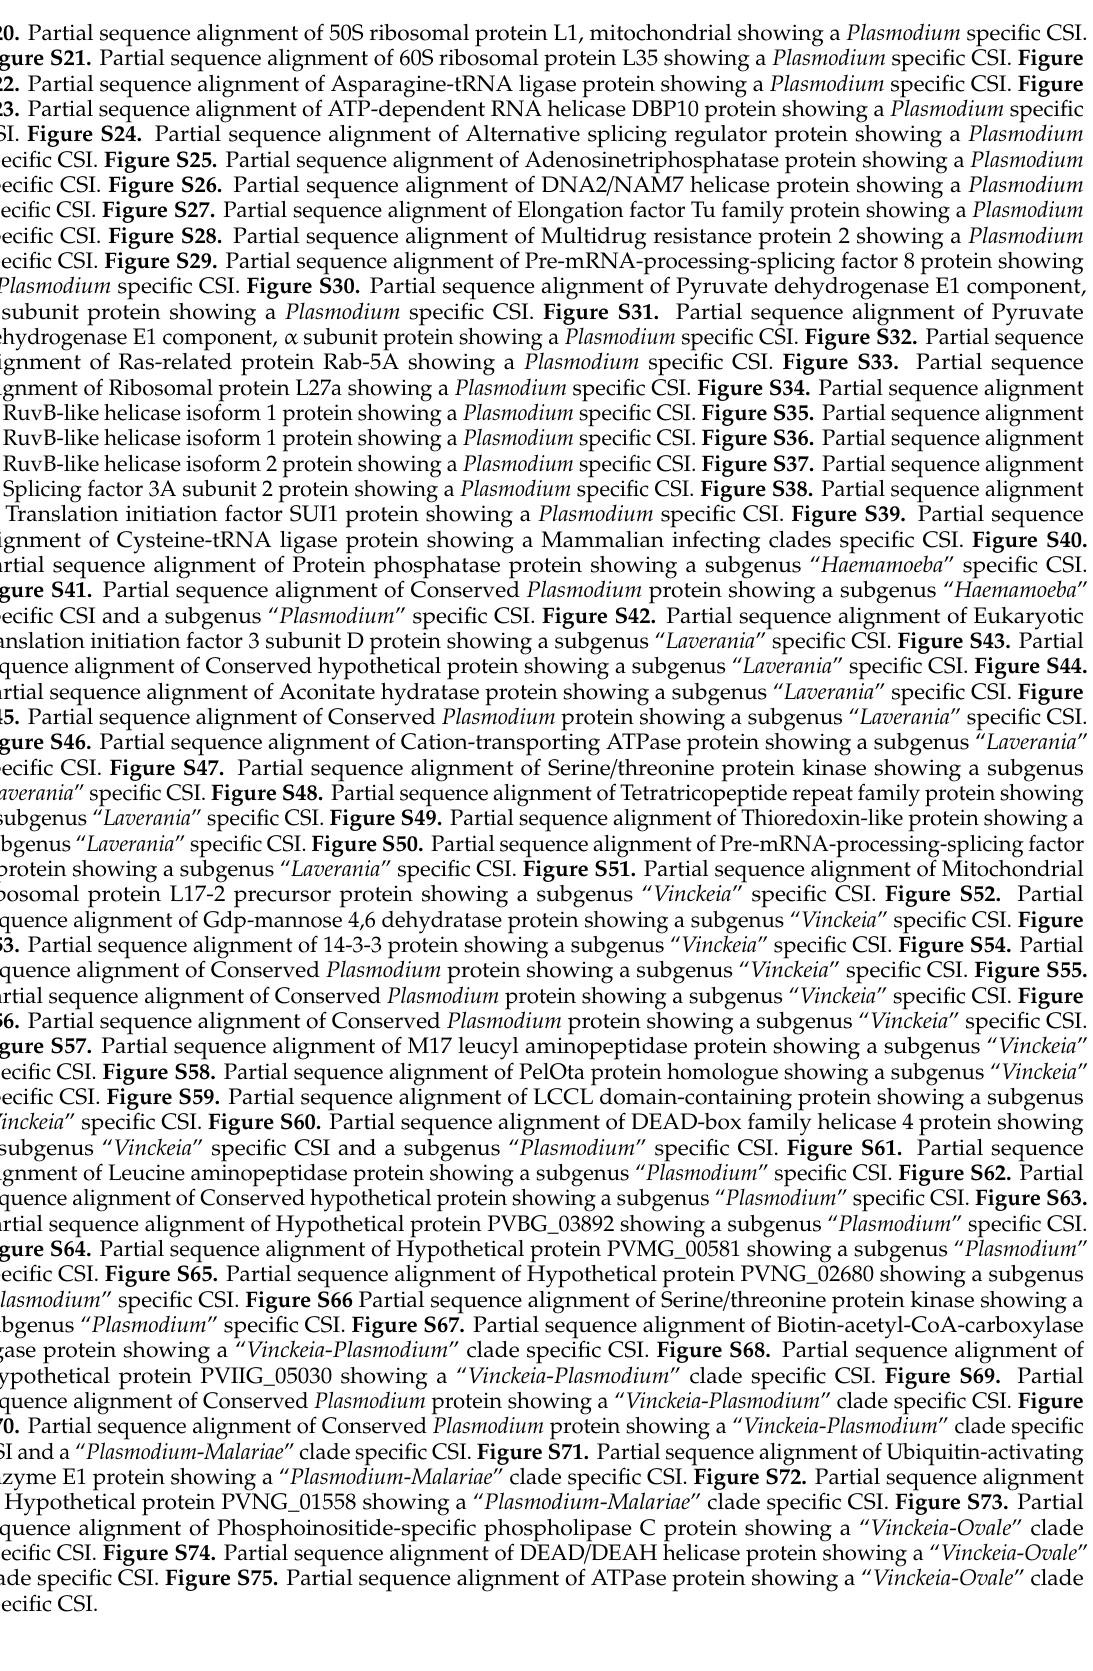
S20. Partial sequence alignment of 50S ribosomal protein L1, mitochondrial showing a Plasmodium specific CSI. Figure S21. Partial sequence alignment of 60S ribosomal protein L35 showing a Plasmodium specific CSI. Figure S22. Partial sequence alignment of Asparagine-tRNA ligase protein showing a Plasmodium specific CSI. Figure S23. Partial sequence alignment of ATP-dependent RNA helicase DBP10 protein showing a Plasmodium specific CSI. Figure S24. Partial sequence alignment of Alternative splicing regulator protein showing a Plasmodium specific CSI. Figure S25. Partial sequence alignment of Adenosinetriphosphatase protein showing a Plasmodium specific CSI. Figure S26. Partial sequence alignment of DNA2 / NAM7 helicase protein showing a Plasmodium specific CSI. Figure S27. Partial sequence alignment of Elongation factor Tu family protein showing a Plasmodium specific CSI. Figure S28. Partial sequence alignment of Multidrug resistance protein 2 showing a Plasmodium specific CSI. Figure S29. Partial sequence alignment of Pre-mRNA-processing-splicing factor 8 protein showing a Plasmodium specific CSI. Figure S30. Partial sequence alignment of Pyruvate dehydrogenase E1 component, α subunit protein showing a Plasmodium specific CSI. Figure S31. Partial sequence alignment of Pyruvate dehydrogenase E1 component, α subunit protein showing a Plasmodium specific CSI. Figure S32. Partial sequence alignment of Ras-related protein Rab-5A showing a Plasmodium specific CSI. Figure S33. Partial sequence alignment of Ribosomal protein L27a showing a Plasmodium specific CSI. Figure S34. Partial sequence alignment of RuvB-like helicase isoform 1 protein showing a Plasmodium specific CSI. Figure S35. Partial sequence alignment of RuvB-like helicase isoform 1 protein showing a Plasmodium specific CSI. Figure S36. Partial sequence alignment of RuvB-like helicase isoform 2 protein showing a Plasmodium specific CSI. Figure S37. Partial sequence alignment of Splicing factor 3A subunit 2 protein showing a Plasmodium specific CSI. Figure S38. Partial sequence alignment of Translation initiation factor SUI1 protein showing a Plasmodium specific CSI. Figure S39. Partial sequence alignment of Cysteine-tRNA ligase protein showing a Mammalian infecting clades specific CSI. Figure S40. Partial sequence alignment of Protein phosphatase protein showing a subgenus “ Haemamoeba ” specific CSI. Figure S41. Partial sequence alignment of Conserved Plasmodium protein showing a subgenus “ Haemamoeba ” specific CSI and a subgenus “ Plasmodium ” specific CSI. Figure S42. Partial sequence alignment of Eukaryotic translation initiation factor 3 subunit D protein showing a subgenus “ Laverania ” specific CSI. Figure S43. Partial sequence alignment of Conserved hypothetical protein showing a subgenus “ Laverania ” specific CSI. Figure S44. Partial sequence alignment of Aconitate hydratase protein showing a subgenus “ Laverania ” specific CSI. Figure S45. Partial sequence alignment of Conserved Plasmodium protein showing a subgenus “ Laverania ” specific CSI. Figure S46. Partial sequence alignment of Cation-transporting ATPase protein showing a subgenus “ Laverania ” specific CSI. Figure S47. Partial sequence alignment of Serine / threonine protein kinase showing a subgenus “ Laverania ” specific CSI. Figure S48. Partial sequence alignment of Tetratricopeptide repeat family protein showing a subgenus “ Laverania ” specific CSI. Figure S49. Partial sequence alignment of Thioredoxin-like protein showing a subgenus “ Laverania ” specific CSI. Figure S50. Partial sequence alignment of Pre-mRNA-processing-splicing factor 8 protein showing a subgenus “ Laverania ” specific CSI. Figure S51. Partial sequence alignment of Mitochondrial ribosomal protein L17-2 precursor protein showing a subgenus “ Vinckeia ” specific CSI. Figure S52. Partial sequence alignment of Gdp-mannose 4,6 dehydratase protein showing a subgenus “ Vinckeia ” specific CSI. Figure S53. Partial sequence alignment of 14-3-3 protein showing a subgenus “ Vinckeia ” specific CSI. Figure S54. Partial sequence alignment of Conserved Plasmodium protein showing a subgenus “ Vinckeia ” specific CSI. Figure S55. Partial sequence alignment of Conserved Plasmodium protein showing a subgenus “ Vinckeia ” specific CSI. Figure S56. Partial sequence alignment of Conserved Plasmodium protein showing a subgenus “ Vinckeia ” specific CSI. Figure S57. Partial sequence alignment of M17 leucyl aminopeptidase protein showing a subgenus “ Vinckeia ” specific CSI. Figure S58. Partial sequence alignment of PelOta protein homologue showing a subgenus “ Vinckeia ” specific CSI. Figure S59. Partial sequence alignment of LCCL domain-containing protein showing a subgenus “ Vinckeia ” specific CSI. Figure S60. Partial sequence alignment of DEAD-box family helicase 4 protein showing a subgenus “ Vinckeia ” specific CSI and a subgenus “ Plasmodium ” specific CSI. Figure S61. Partial sequence alignment of Leucine aminopeptidase protein showing a subgenus “ Plasmodium ” specific CSI. Figure S62. Partial sequence alignment of Conserved hypothetical protein showing a subgenus “ Plasmodium ” specific CSI. Figure S63. Partial sequence alignment of Hypothetical protein PVBG_03892 showing a subgenus “ Plasmodium ” specific CSI. Figure S64. Partial sequence alignment of Hypothetical protein PVMG_00581 showing a subgenus “ Plasmodium ” specific CSI. Figure S65. Partial sequence alignment of Hypothetical protein PVNG_02680 showing a subgenus “ Plasmodium ” specific CSI. Figure S66 Partial sequence alignment of Serine / threonine protein kinase showing a subgenus “ Plasmodium ” specific CSI. Figure S67. Partial sequence alignment of Biotin-acetyl-CoA-carboxylase ligase protein showing a “ Vinckeia - Plasmodium ” clade specific CSI. Figure S68. Partial sequence alignment of Hypothetical protein PVIIG_05030 showing a “ Vinckeia - Plasmodium ” clade specific CSI. Figure S69. Partial sequence alignment of Conserved Plasmodium protein showing a “ Vinckeia - Plasmodium ” clade specific CSI. Figure S70. Partial sequence alignment of Conserved Plasmodium protein showing a “ Vinckeia - Plasmodium ” clade specific CSI and a “ Plasmodium - Malariae ” clade specific CSI. Figure S71. Partial sequence alignment of Ubiquitin-activating enzyme E1 protein showing a “ Plasmodium - Malariae ” clade specific CSI. Figure S72. Partial sequence alignment of Hypothetical protein PVNG_01558 showing a “ Plasmodium - Malariae ” clade specific CSI. Figure S73. Partial sequence alignment of Phosphoinositide-specific phospholipase C protein showing a “ Vinckeia - Ovale ” clade specific CSI. Figure S74. Partial sequence alignment of DEAD / DEAH helicase protein showing a “ Vinckeia - Ovale ” clade specific CSI. Figure S75. Partial sequence alignment of ATPase protein showing a “ Vinckeia - Ovale ” clade specific